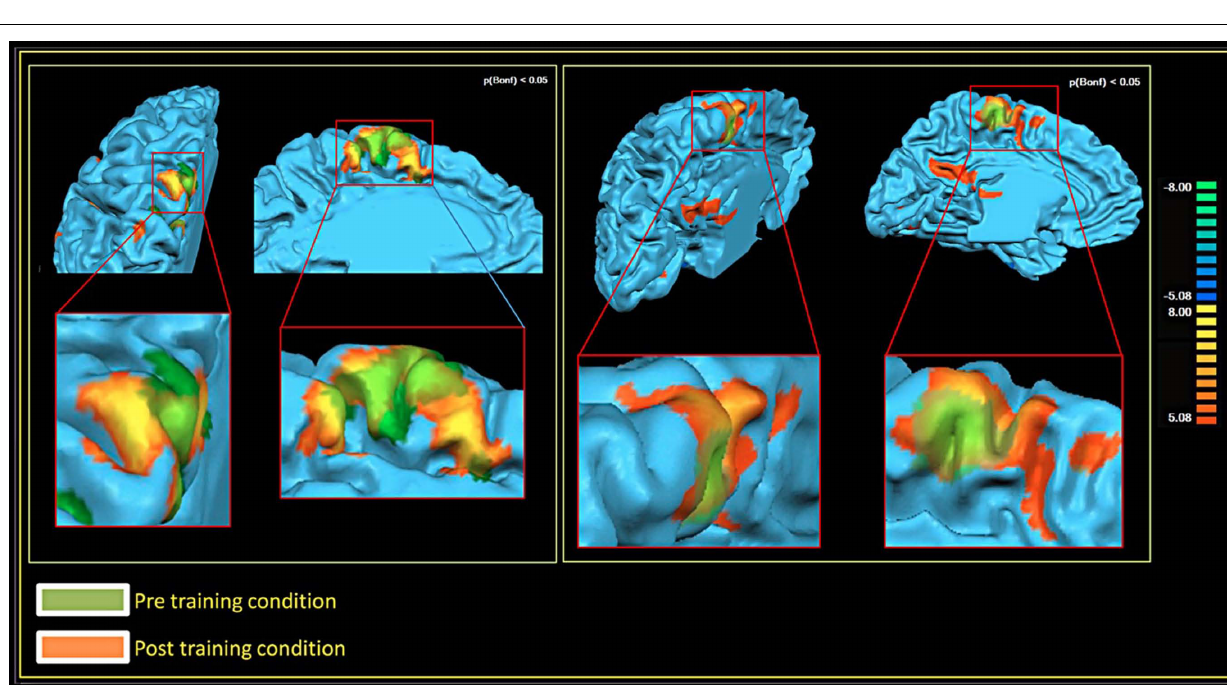
Frontiers in Human